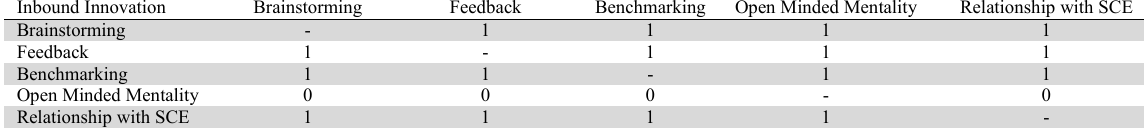
Concordance matrix for the criterion inbound innovation Inbound Innovation